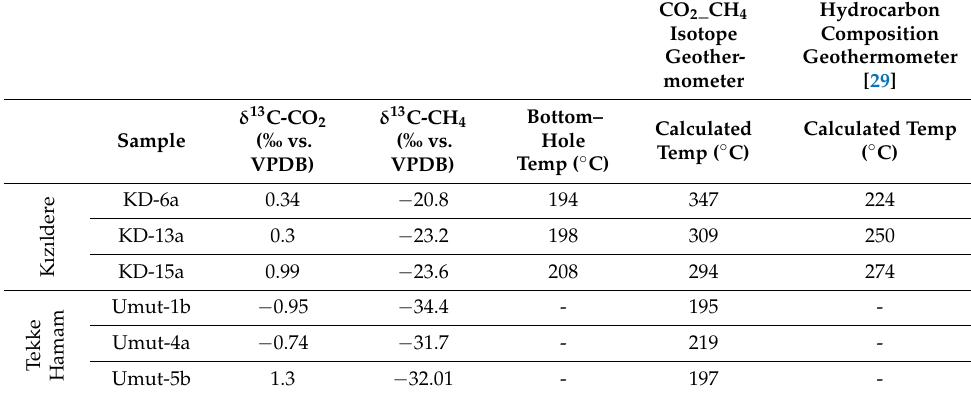
Table 3. Results of isotope geothermometry calculations for Kızıldere and Tekke Hamam gas